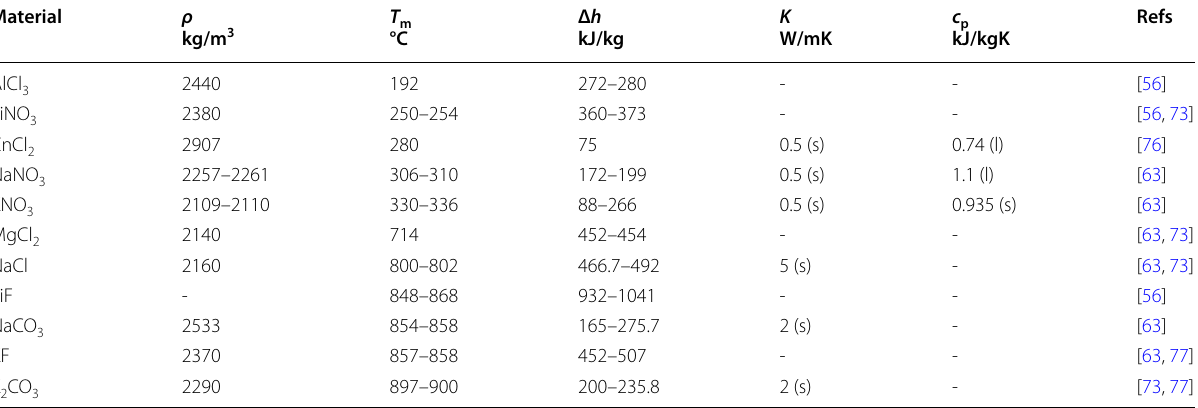
Table 5 Thermophysical properties of selected pure inorganic salts as PCMs